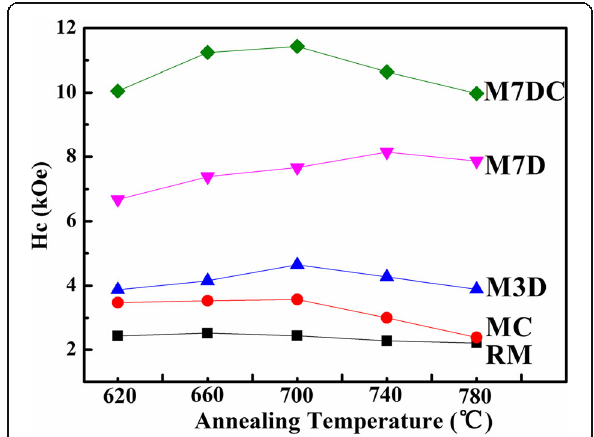
Fig. 4 Coercivity of the samples as a function of the annealing temperature